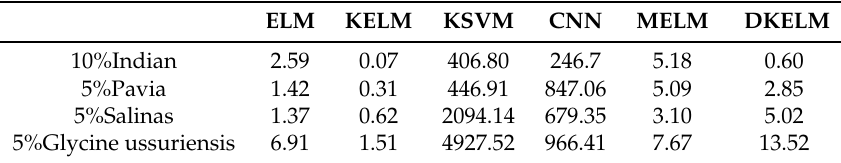
Table 9. Training time (In second) of different algorithms based on four